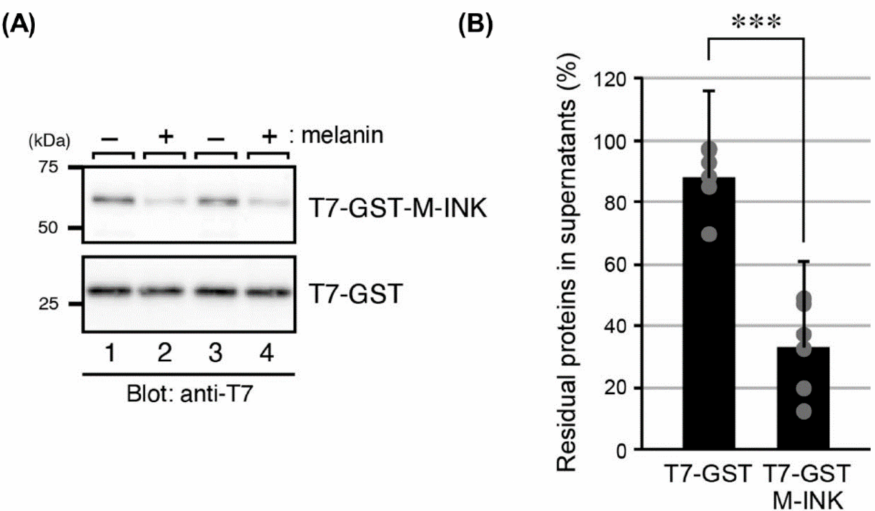
Figure 2. Incubation of T7-glutathione S -transferase (GST)-M-INK with purified melanin in vitro. ( A ) Interaction of T7-GST-M-INK with purified melanin in vitro. T7-GST-M-INK or T7-GST (as a negative control) was incubated for 20 min with ( + ) or without ( − ) melanin, as described in the Materials and Methods. After removal of insoluble melanin by centrifugation, the supernatant was analyzed by 12% SDS-PAGE, followed by immunoblotting with anti-T7 tag antibody; ( B ) the intensity of the bands shown in ( A ) was quantified. Note that T7-GST-M-INK was e ffi ciently depleted from the supernatant by purified melanin. ***, p < 0.001 (Student’s unpaired t